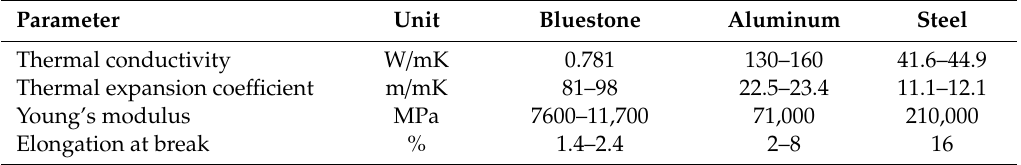
Table 1. Comparison of the material properties of the di ff erent tool materials (Bluestone, aluminum, steel).